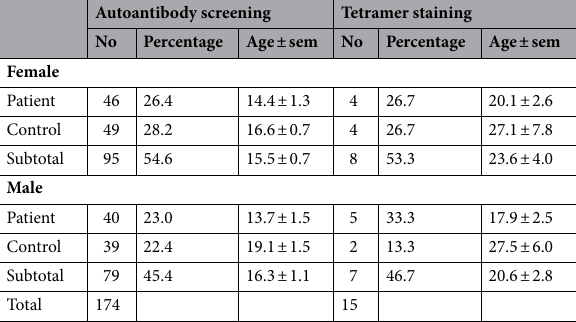
Table 1. Summary of subjects. Sem standard error of the